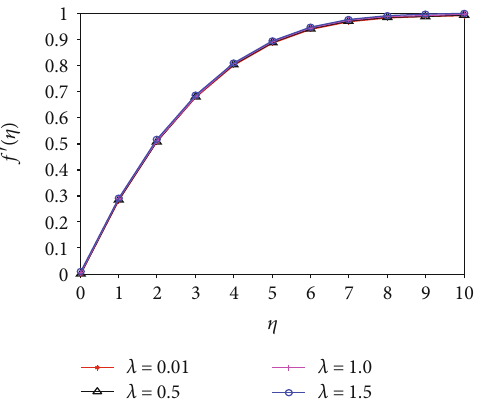
Figure 3: Velocity pro fi les for altered values of λ once Pr = 0 : 72 , Gr = M = Bi = Ra = 0 : 1 .